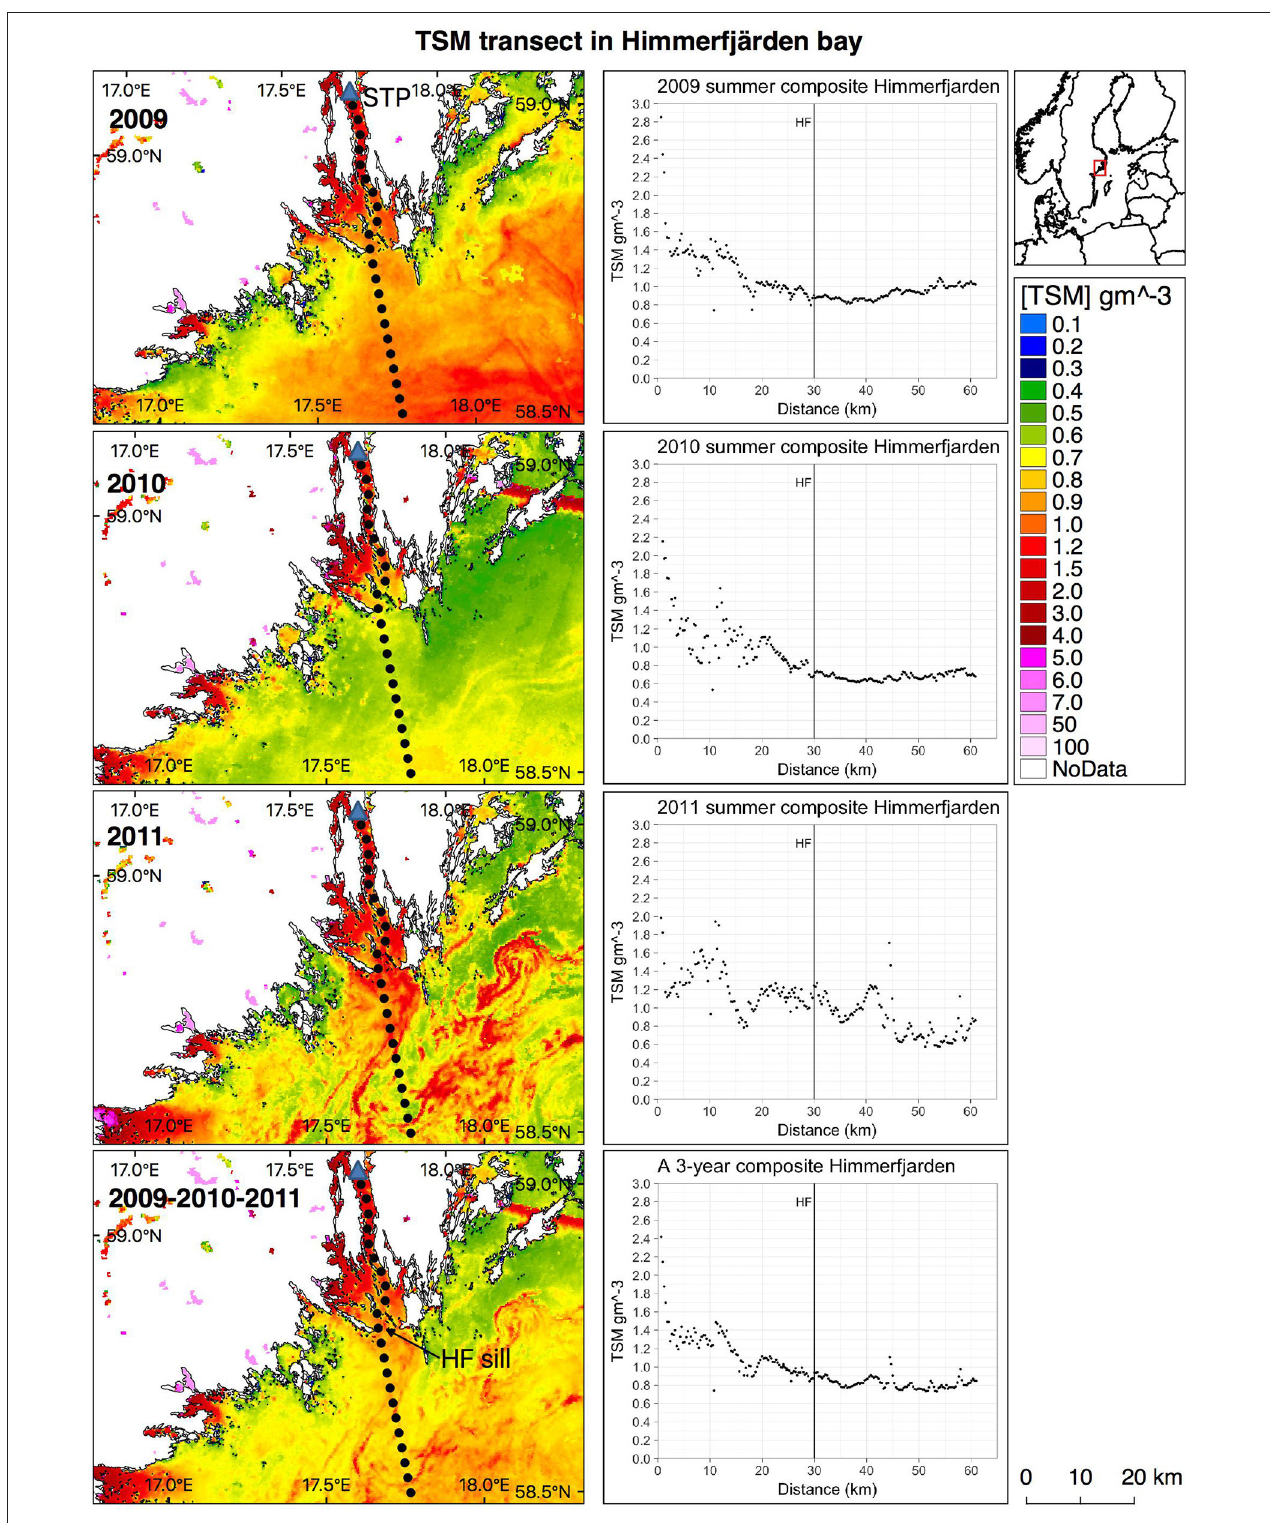
FIGURE 5 | TSM transect derived from composites of three summer seasons 2009, 2010, 2011, and a 3-year summer composite, Himmerfjaärden bay, Sweden. European coastline shapefile (see caption Figure 1 ). Transect plots (R-studio 3.4.1; { ggplot2 } package; Wickham, 2016).